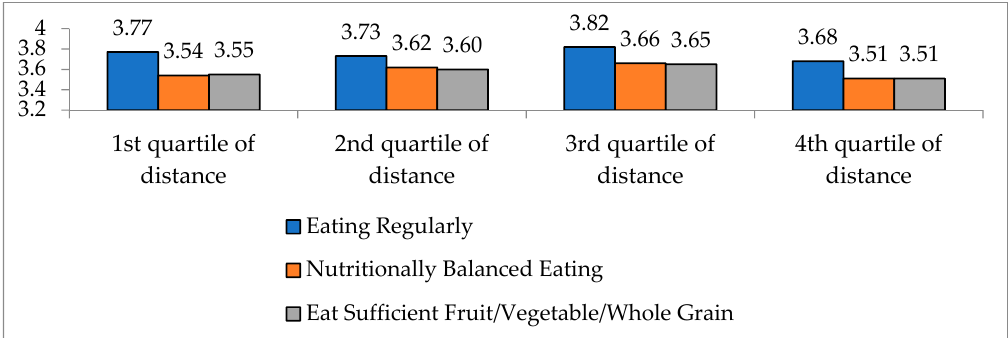
Figure 8. Eating habits by quartile of distance to the nearest grocery store. Note: p -value = 0.000 in t- test Source: Consumer Behavior Survey for Foods [38].